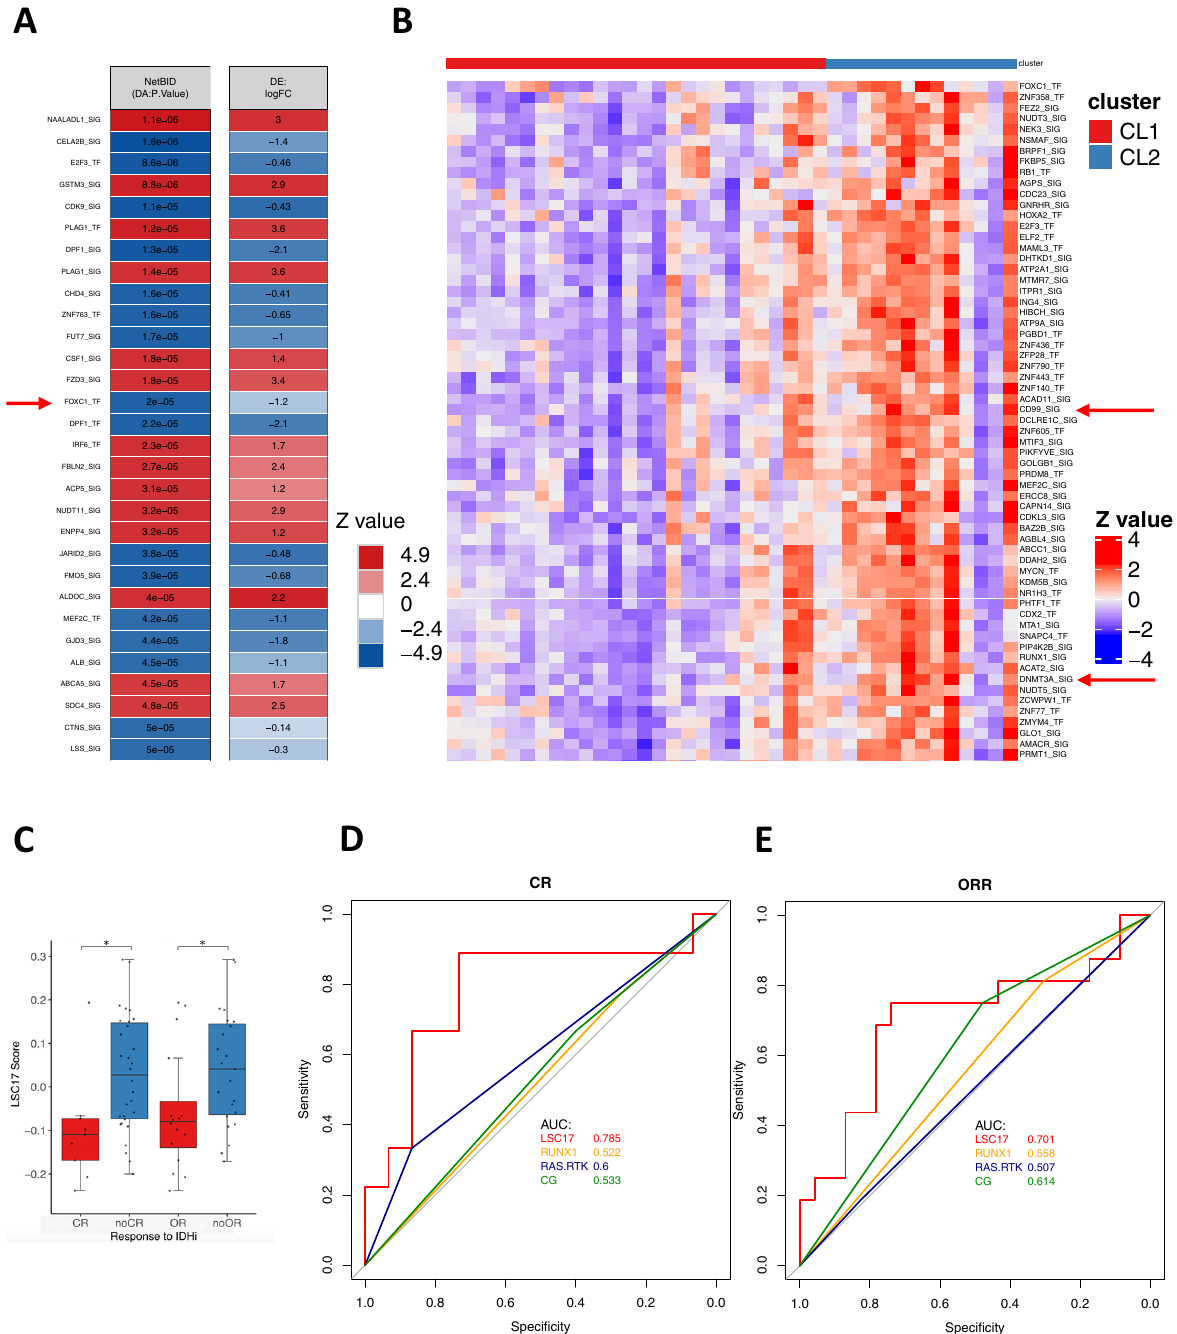
Fig. 3 Leukemia stemness is associated with primary resistance to IDHi. A List of top driver transcription factors (TF) and signaling genes (SIG) identi fi ed by NetBID2 analysis by comparing gene expression pro fi les between cluster 1 and cluster 2 ( P < 0.01 was used as the signi fi cance cutoff). Drivers identi fi ed for cluster 1 and cluster 2 are colored with red and blue, respectively. B Heatmap of NetBID-based activity of top drivers in cluster 2. Samples in cluster 1 (CL1) are labeled as red, while cluster 2 (CL2) are labeled as blue. C LSC17 score was calculated for each baseline sample and compared between patients achieving CR ( N = 9) vs. not ( N = 30) and OR ( N = 16) vs. not ( N = 23). * P < 0.05 ( P = 0.011 for CR vs. non-CR; P = 0.037 for OR vs. non-OR). Box plot shows the minimum, fi rst quartile (Q1), median, third quartile (Q3), and maximum. D , E Receiver operating curve (ROC) for predicting CR or OR with LSC17 score, RUNX1 mutation status, RAS-RTK mutation status, and ELN cytogenetic risk classi fi cation. Source data are provided as Source data fi